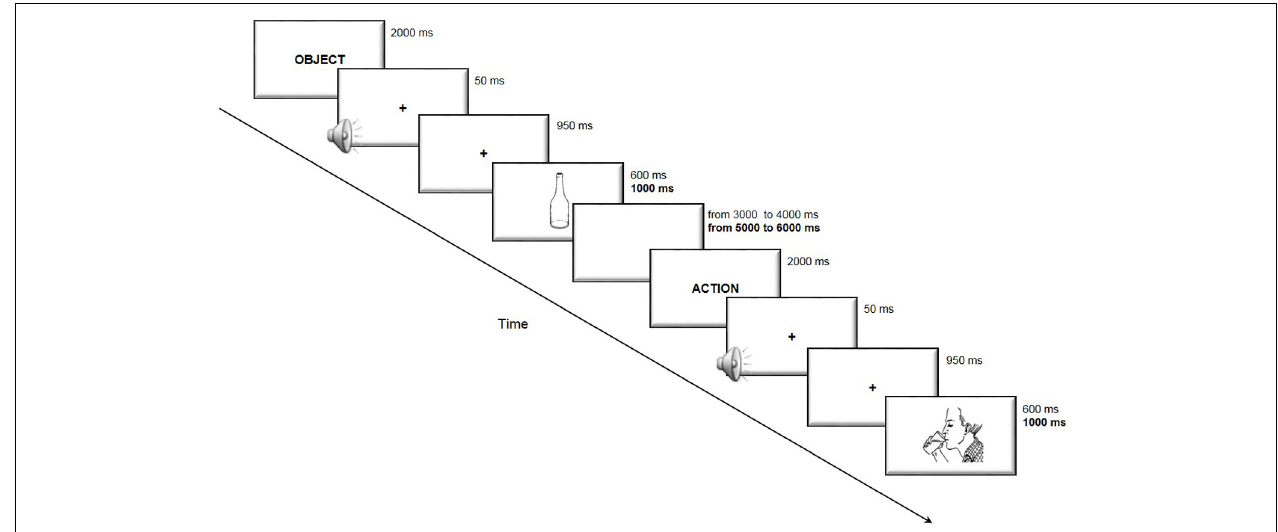
FIGURE 1 | Trial structure of the picture-naming task. The subjects were presented with an indication of the category “action” or “object” immediately before the picture was presented to disambiguate lexical selection. The participants were then required to